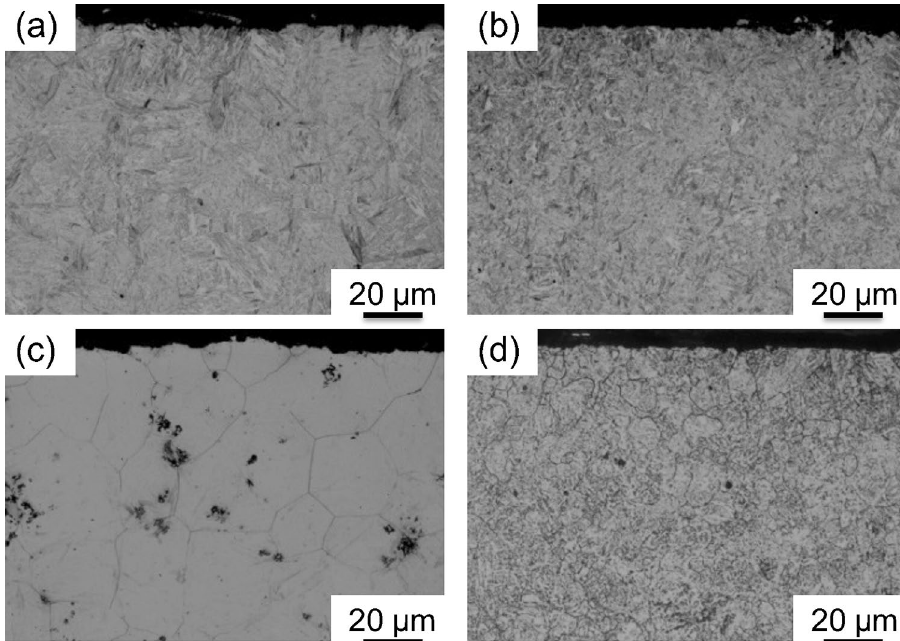
Figure 5. Optical micrographs of microstructures ( a,b ) and crystal grain ( c,d ) of test gears measured at the tooth tip of Sample 1 ( a,c ) and Sample 2 ( b,d ). The microstructure of martensite ( a,b ) was revealed by means of optical microscopy (OM). The crystal grain size ( c , d ) was determined by OM image analysis of the specimens according to ASTM-E112. The average grain diameter of Sample 1 and Sample 2 were estimated to be approximately 26.7 μm (ASTM grain size number #7.5) and 11.2 μm (#10), respectively. In addition, the dark spots in c were corrosion pits induced by inclusions during etching, which was performed strongly to reveal prior austenite grain boundaries.